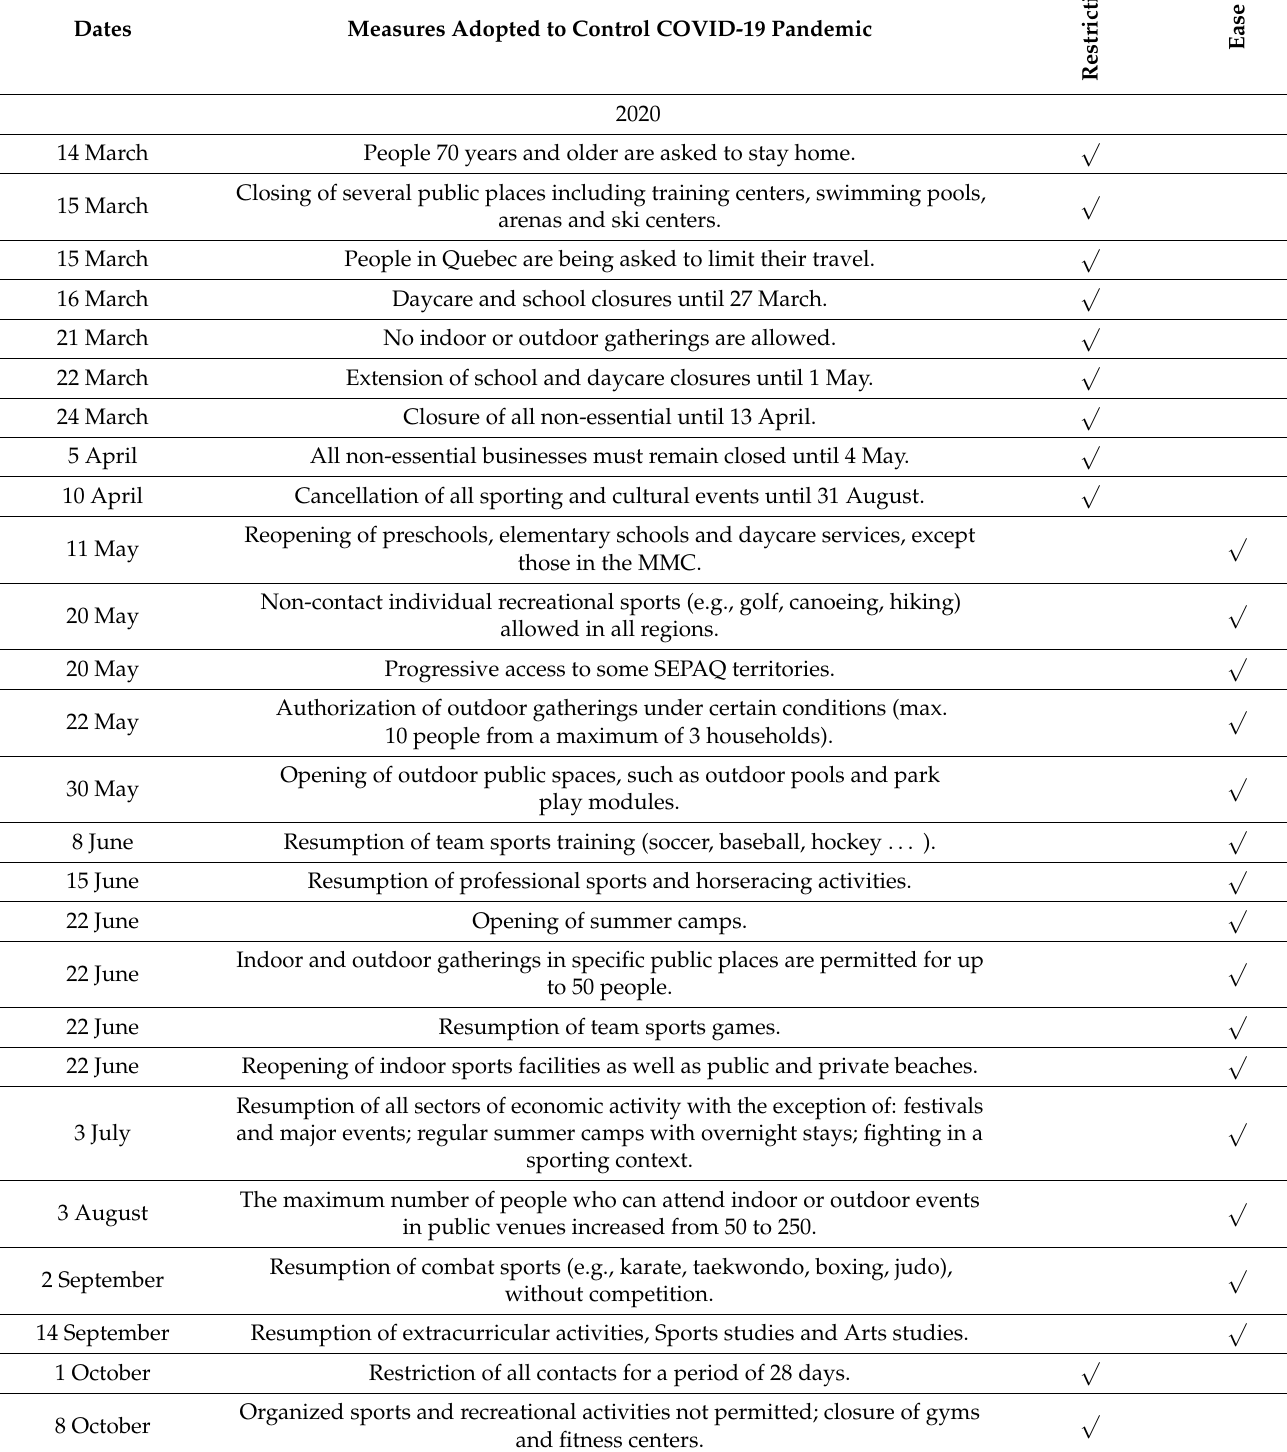
Measures Adopted to Control COVID-19